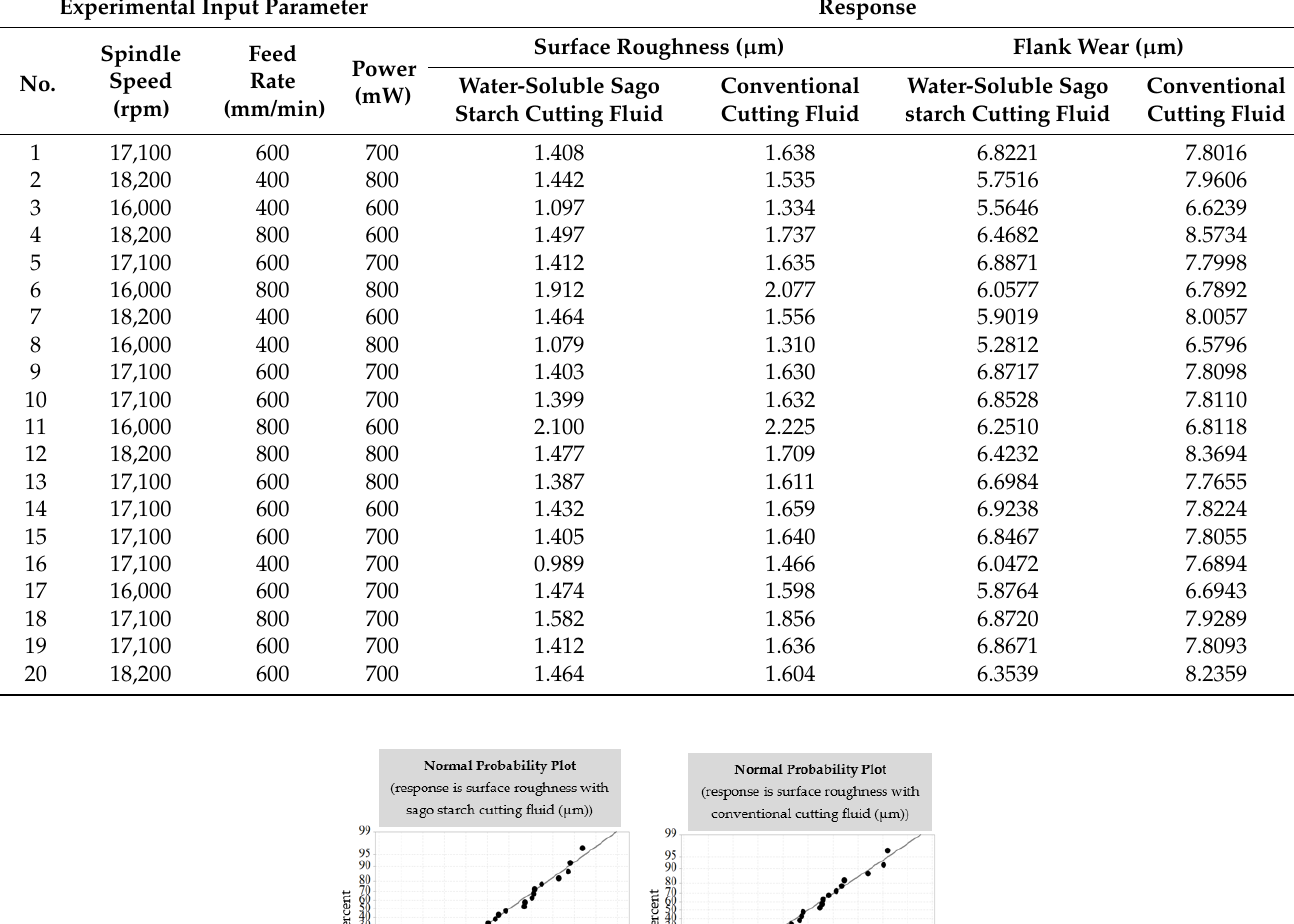
Table 7. Design of experiment and responses.